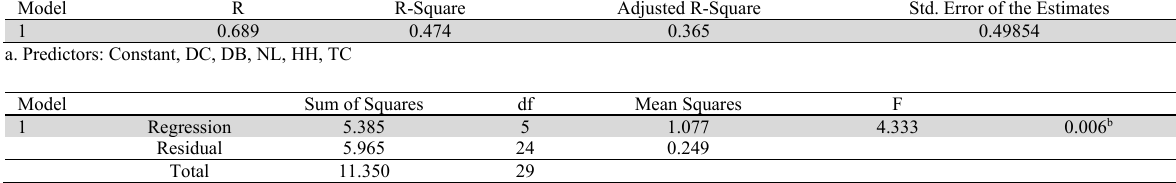
Synthesize the index to analyze multiple regression SERVQUAL scale with the variable of customer satisfaction Model